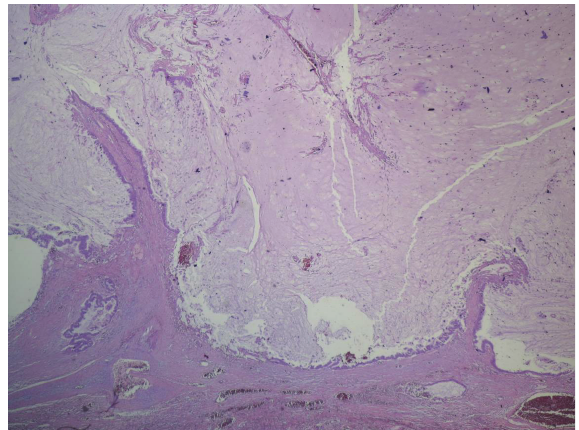
Figure 2: Primary PMCAC. The tumor consists of a large cystic space filled with mucin and lined by columnar neoplastic epithelium. (H&E,